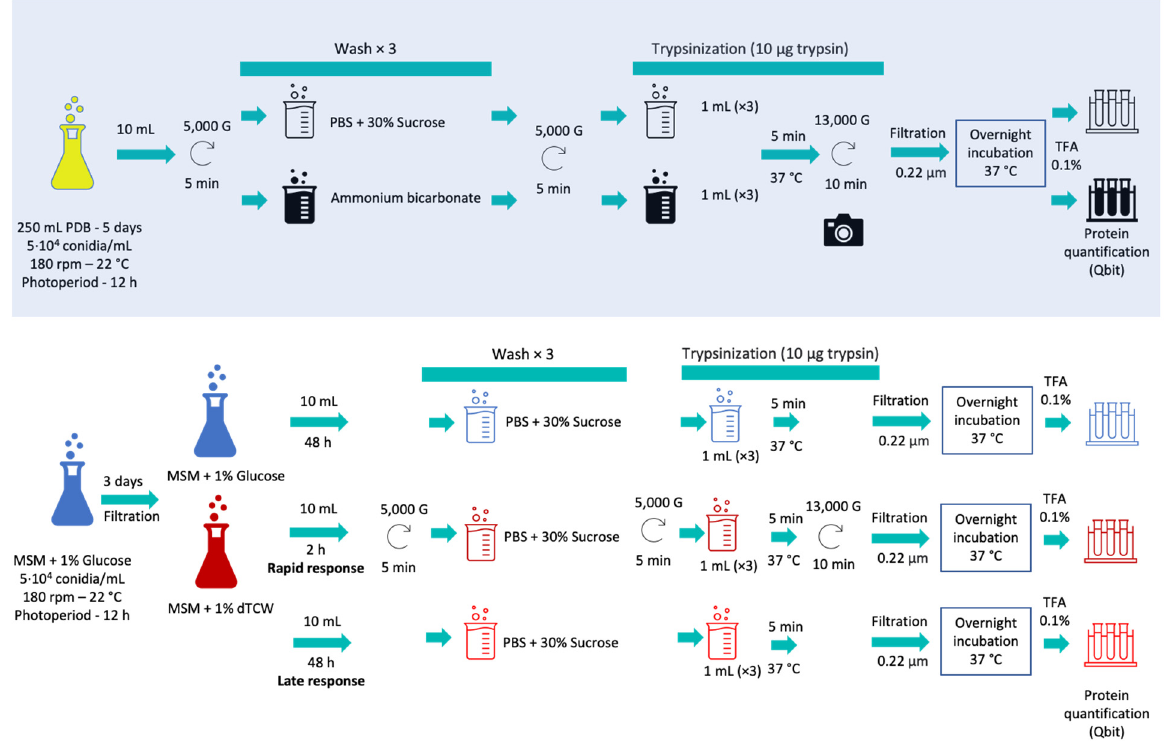
Figure 1. Schematic protocol followed during surfactome optimization (with blue shadow) and during the experimental work with glucose and deproteinized tomato cell wall as sole carbon sources, representing rapid and late responses.